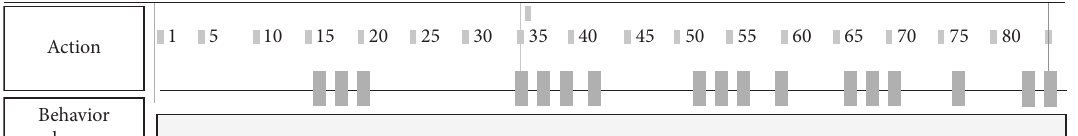
Figure 4: Time axis.